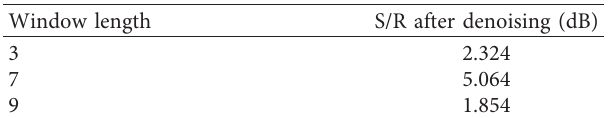
Figure 3: Denoising results by TF-SS with different window lengths. (a) Filtering with the window length of 3. (b) Filtering with the window length of 7. (c) Filtering with the window length of 9. Table 1: Comparison of S/R after denoising with different filter window